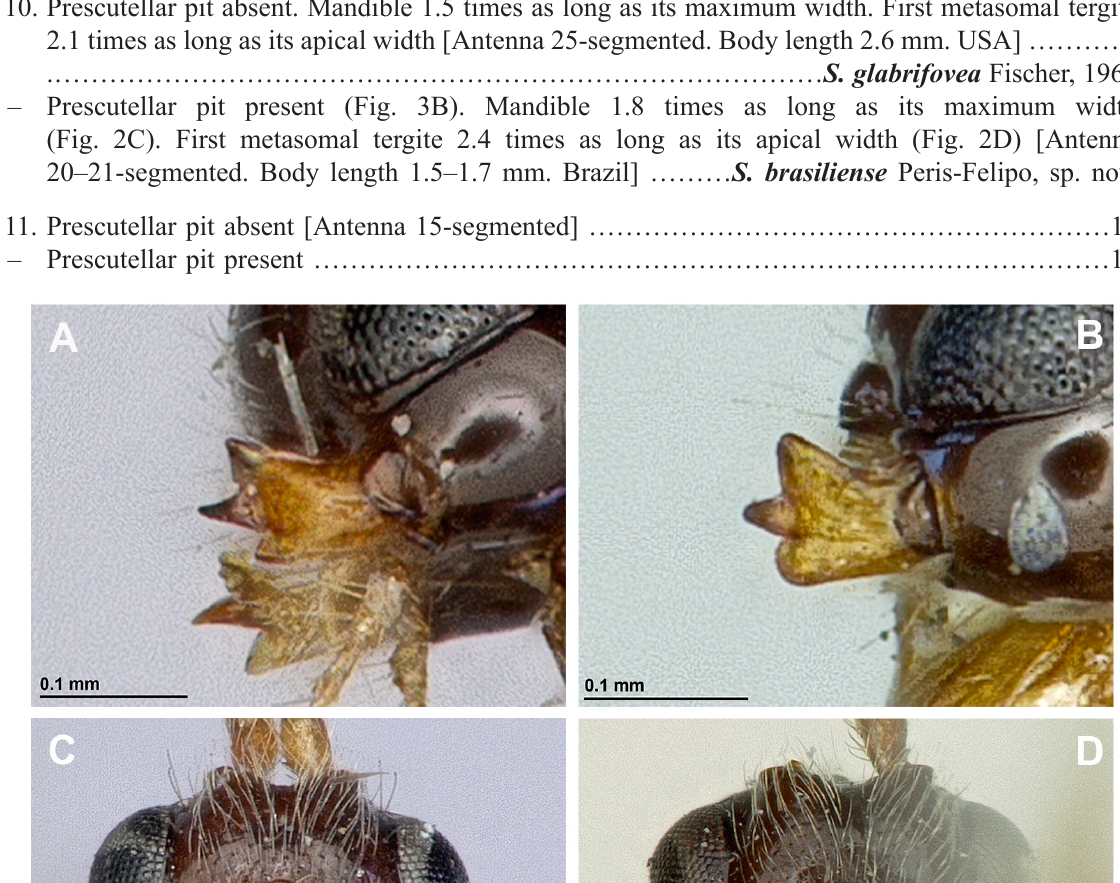
10. Prescutellar pit absent. Mandible 1.5 times as long as its maximum width. First metasomal tergite 2.1 times as long as its apical width [Antenna 25-segmented. Body length 2.6 mm. USA] ………… – Prescutellar pit present (Fig. 3B). Mandible 1.8 times as long as its maximum width (Fig. 2C). First metasomal tergite 2.4 times as long as its apical width (Fig. 2D) [Antenna 20–21-segmented. Body length 1.5–1.7 mm. Brazil] ……… S. brasiliense Peris-Felipo, sp. nov.